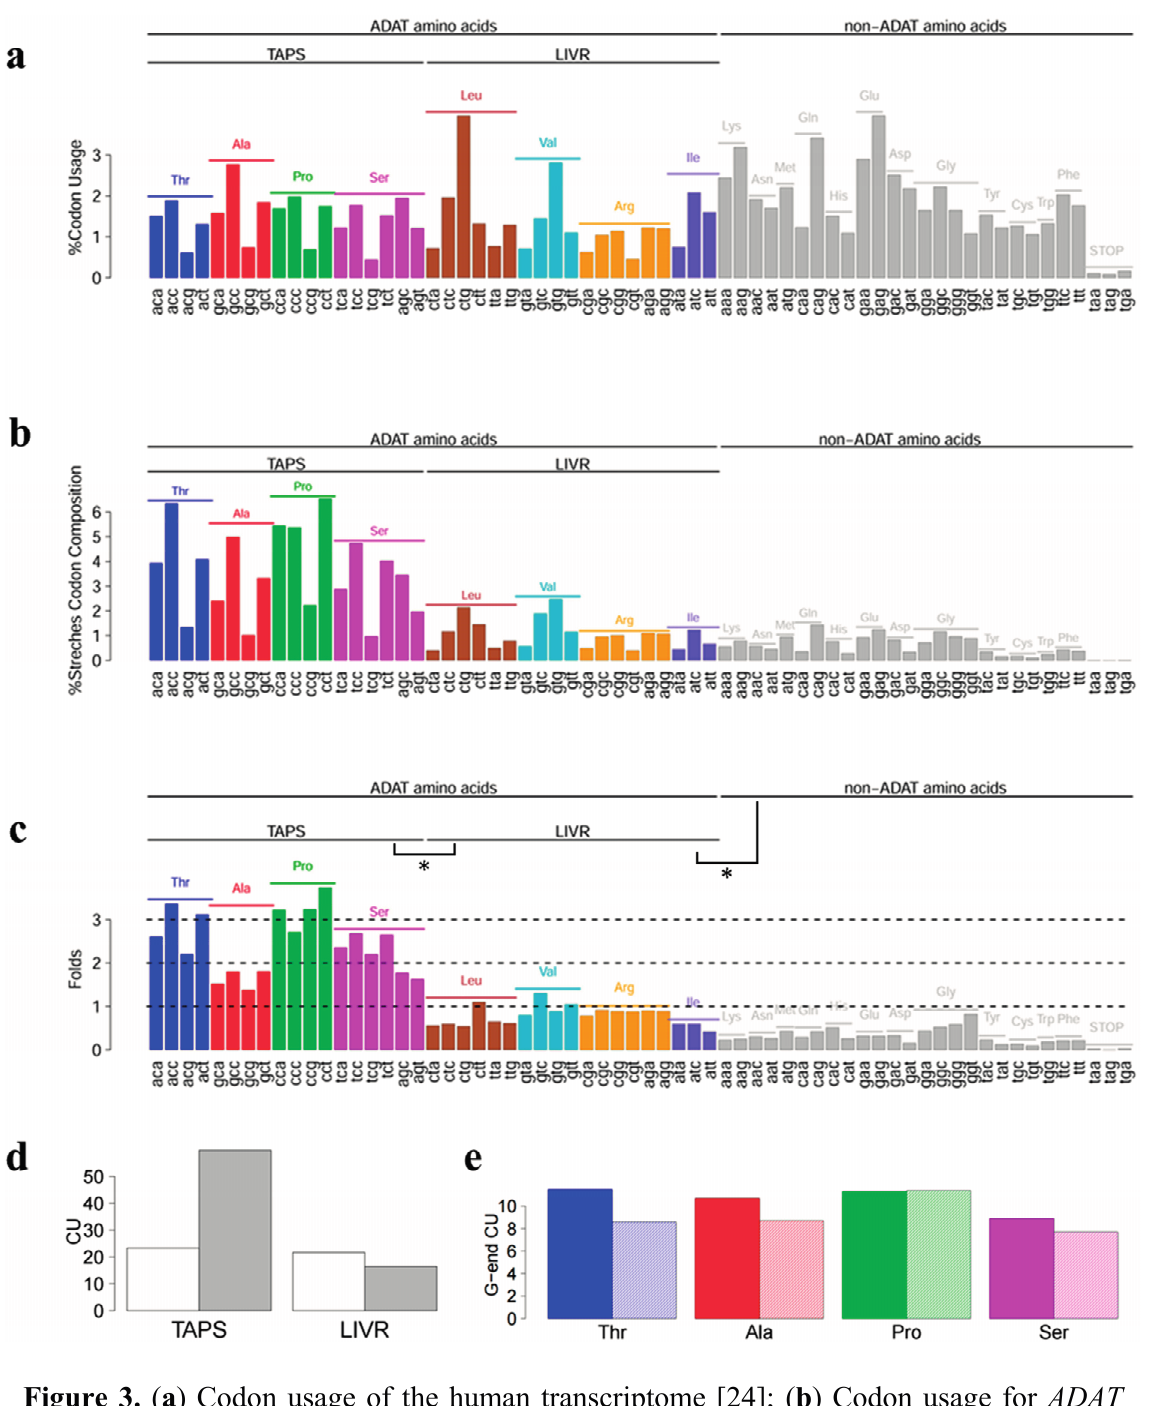
Figure 3. ( a ) Codon usage of the human transcriptome [24]; ( b ) Codon usage for ADAT stretches . A codons are colored with a different color for each ADAT amino acid. ( a , b ) Each percentage is measured with respect to the total of codons, thus all the bars sums 100%; ( c ) Fold increase of ADAT stretches ( b ) normalized by human codon usage ( a ). There are significant differences (see asterisks *) between sets of TAPS and LIVR ( p -value = 10 − 7 ), and sets of LIVR and the non-ADAT amino acids ( p -value = 5 × 10 − 8 ). One-tail Wilcoxon test was applied in both cases with confidence level 0.95; ( d ) Codon usage for TAPS or LIVR codons in the human transcriptome (white) or in the ADAT stretch regions (grey); ( e ) Codon usage for G-ended codons for TAPS in the human transcriptome (colored) or in the ADAT stretches (dashed